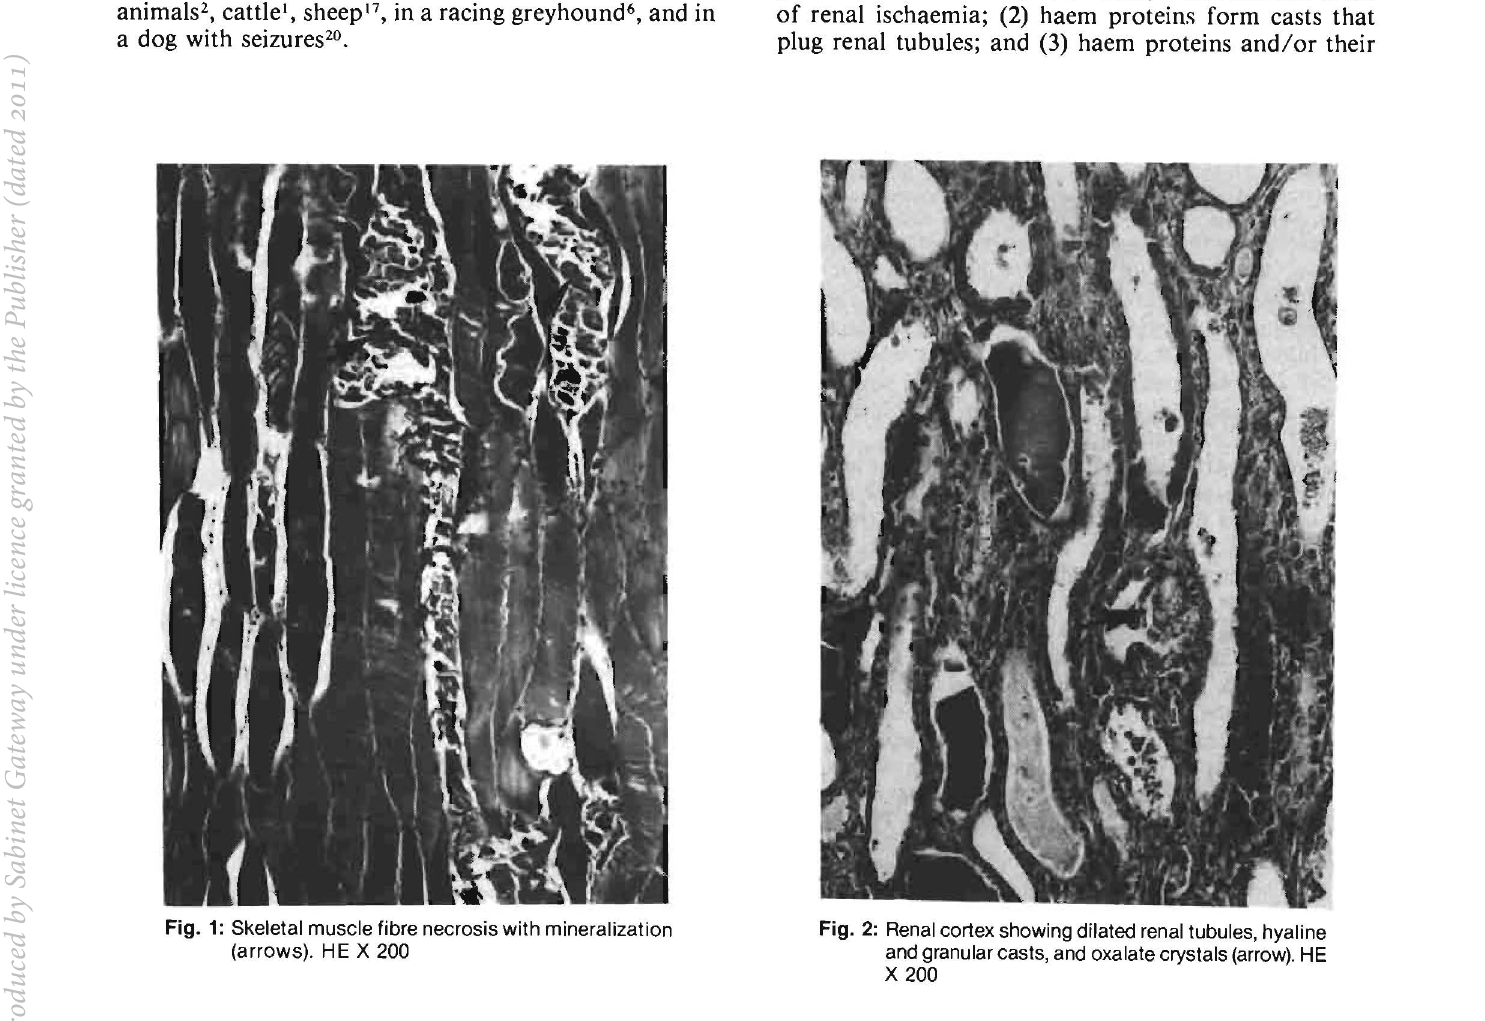
Fig. 1: Skeletal muscle fibre necrosis with mineralization (arrows). HE X 200 p TYDSKRIF VAN DIE SUID-AFRIKAANSE VETERINERE VERENIGING - JUNIE 1982 e R